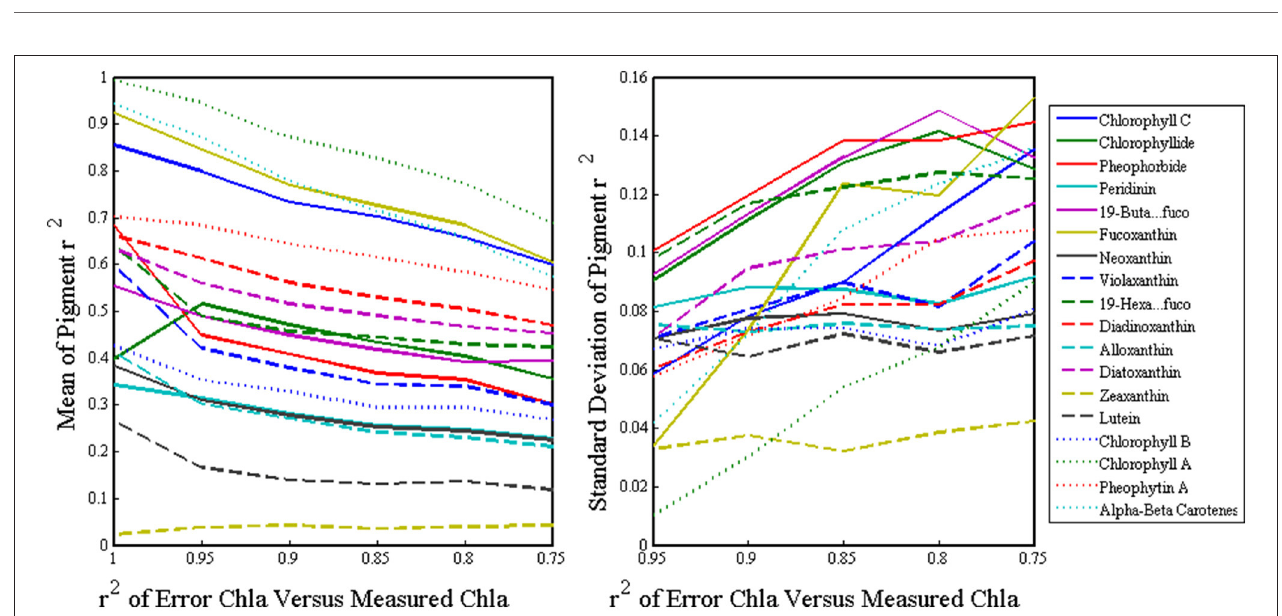
FIGURE 7 | The x-axes are the r 2 of the Chl HPLC versus the Chl HPLC with normal random error added, where 1 is Chl HPLC with no error and 0.75 is equivalent to the error of Chl SAT . The y-axes depict the mean (left) and standard deviation (right) of the r 2 values of the measured versus predicted pigment concentrations after the inversions are run with errored Chl HPLC for hundred of iterations.